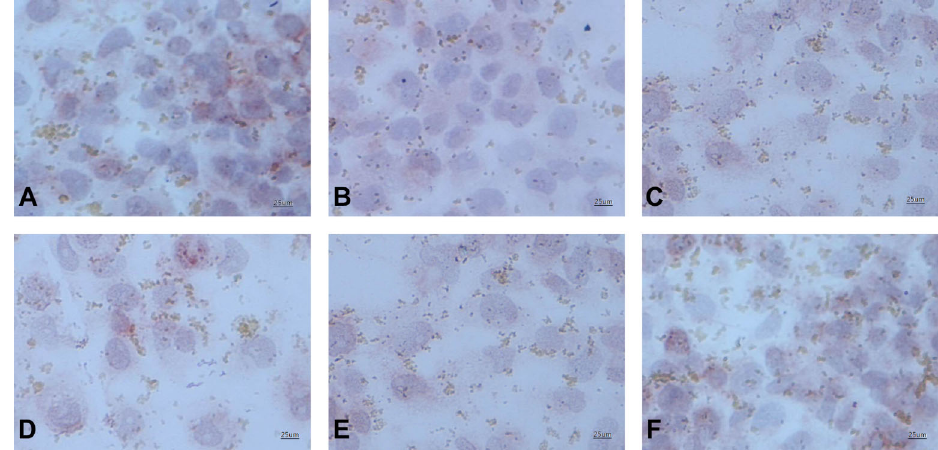
Figure 12. Immunocytochemical images (400 6 ) of Bcl-2 expression in SMMC-7721 hepatoma cells. A , Control group A (RPMI 1640 culture medium only); B , spiking group (8 g/L Fe 2 O 3 , no radiation); C , 2 g/L Fe 2 O 3 MFH group; D , 4 g/L Fe 2 O 3 MFH group; E , 6 g/L Fe 2 O 3 MFH group; F , 8 g/L Fe 2 O 3 MFH group. MFH: magnetic fluid